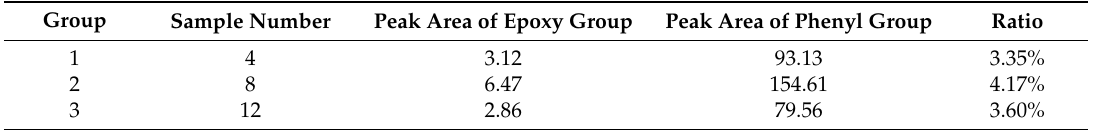
Table 4. Peak area of the two functional